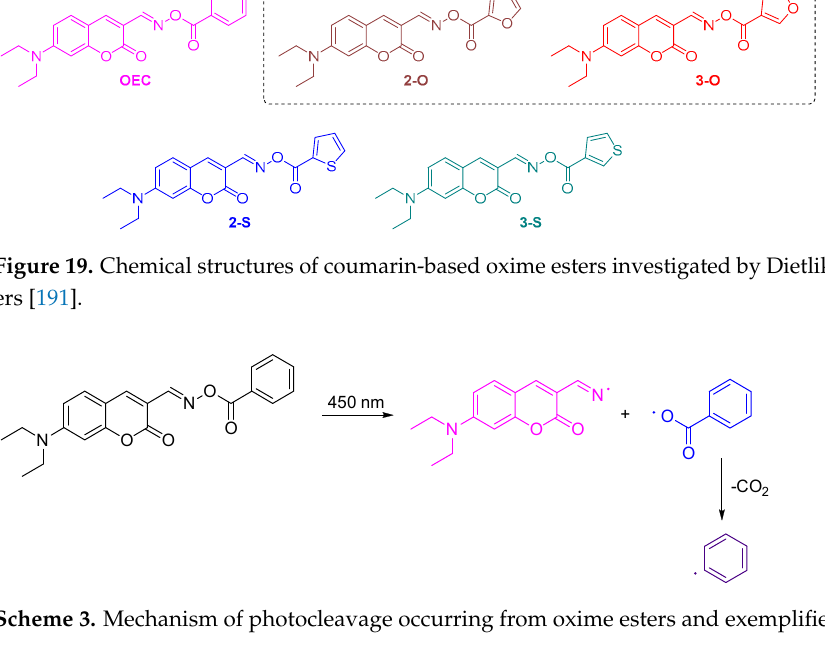
Figure 20. UV-visible absorption of 2-O, 2-S, 3-O, and 3-S at room temperature. Reproduced with permission of Ref. [191]. Photoinitiating abilities of the different dyes were investigated at 450 nm and the tetrafunctional monomer TMPTA was selected for this study. Upon irradiation at 450 nm, the thiophenyl derivatives (2-S and 3-S) greatly outperformed the furanyl-based oxime esters (2-O and 3-O) (See Figure 21). Comparison between 2-O, 3-O, 2-S, and 3-S evidenced the 2-substituted heterocycles to outperform the 3-substituted heterocycles in terms of fi- nal monomer conversions. Comparison with OEC used as a reference oxime ester re- vealed all newly developed oxime esters to furnish lower monomer conversions than OEC. In fact, only the thiophene derivative 2-S could furnish monomer conversions ap- proaching that of OEC. Figure 21. Monomer conversions obtained during the FRP of TMPTA using different oxime esters, irradiation at 450 nm with a LED (30 mW/cm 2 ). Reproduced with permission of Ref. [191] .